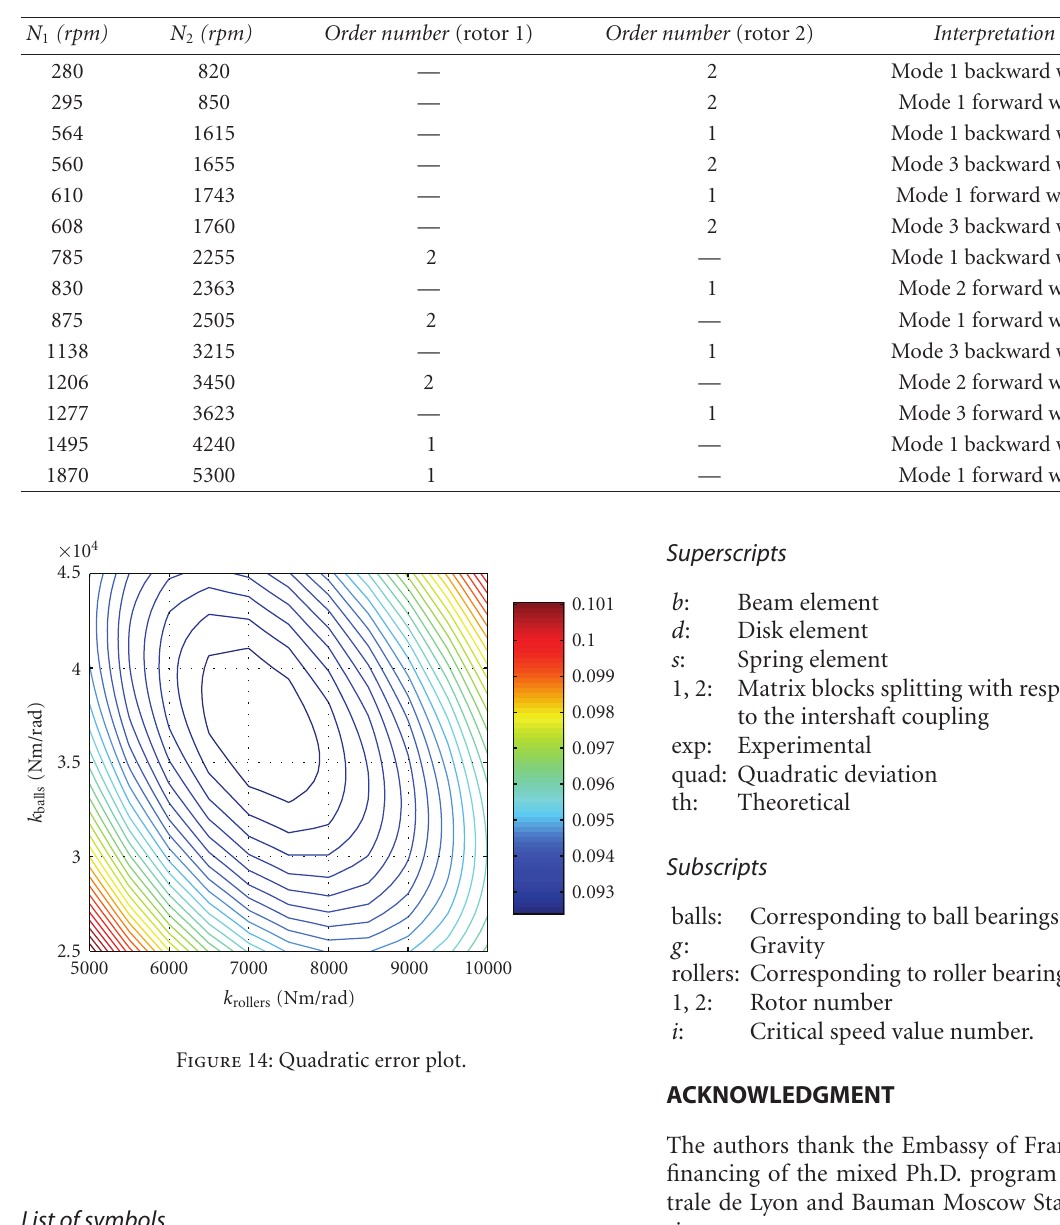
Table 3: Experimentally observed peaks.